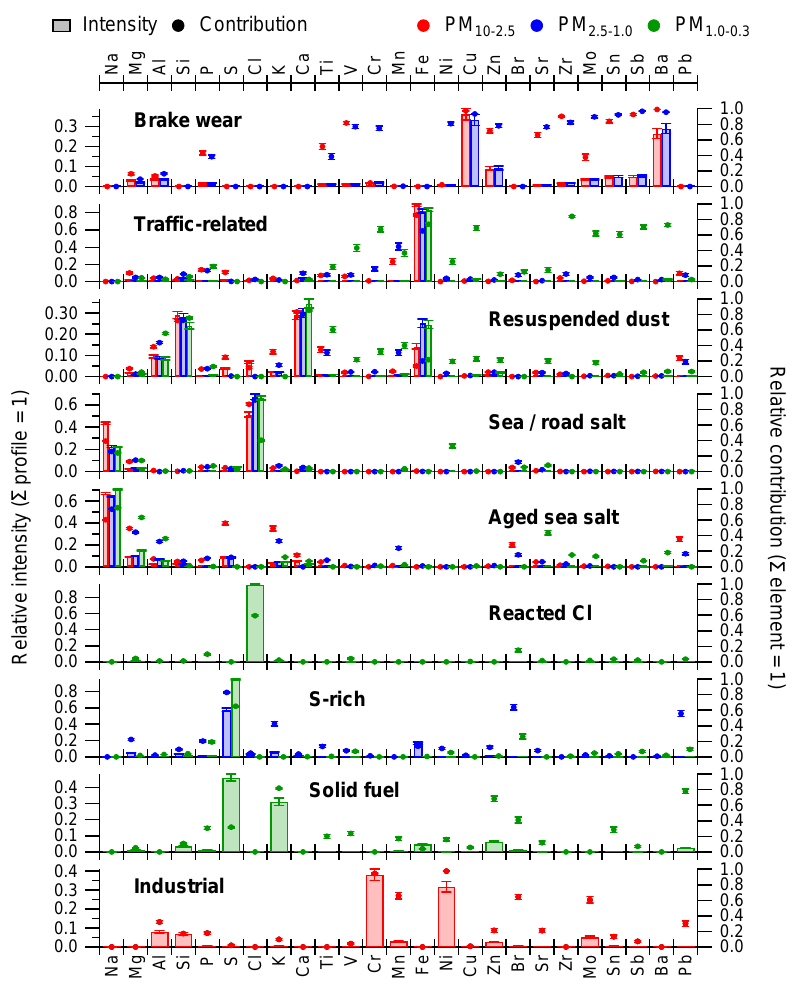
Figure 3. Source profiles of ME-2 results on combined data of the MR-NK-DE sites. The bars (left y axis) represent the average element intensity to each factor in ngng − 1 ; circles (right y axis) represent the fraction of the total predicted concentration for a given element. Data are given as mean of good solutions ± 1SD from the anchor sensitivity analysis. Note that not all factors are retrieved in all size fractions. See Supplement Tables S1–S3 for the